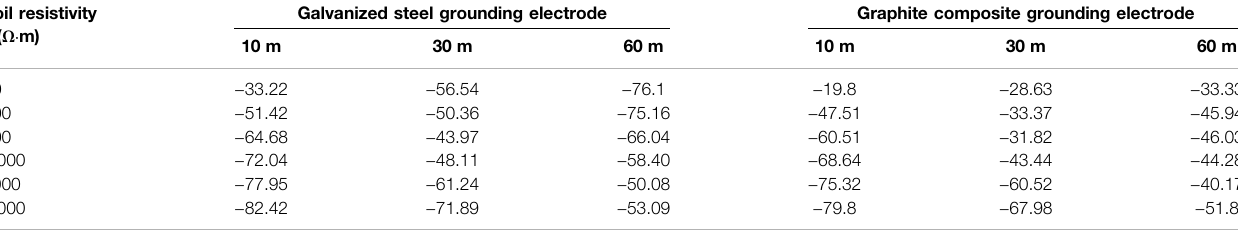
TABLE 5 | In fl uence rate η D of spark discharge effect (%).